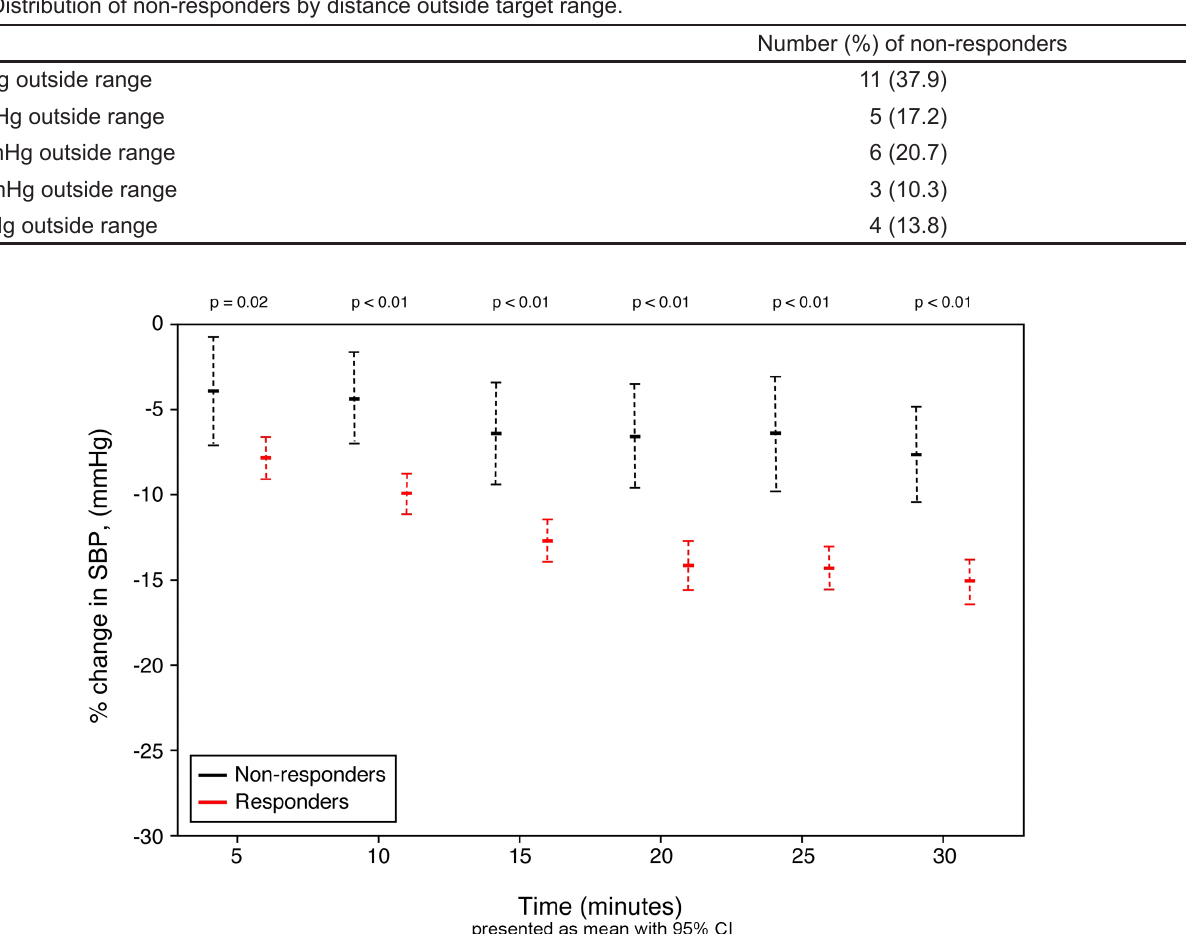
Figure 2. Change in systolic blood pressure measurements over